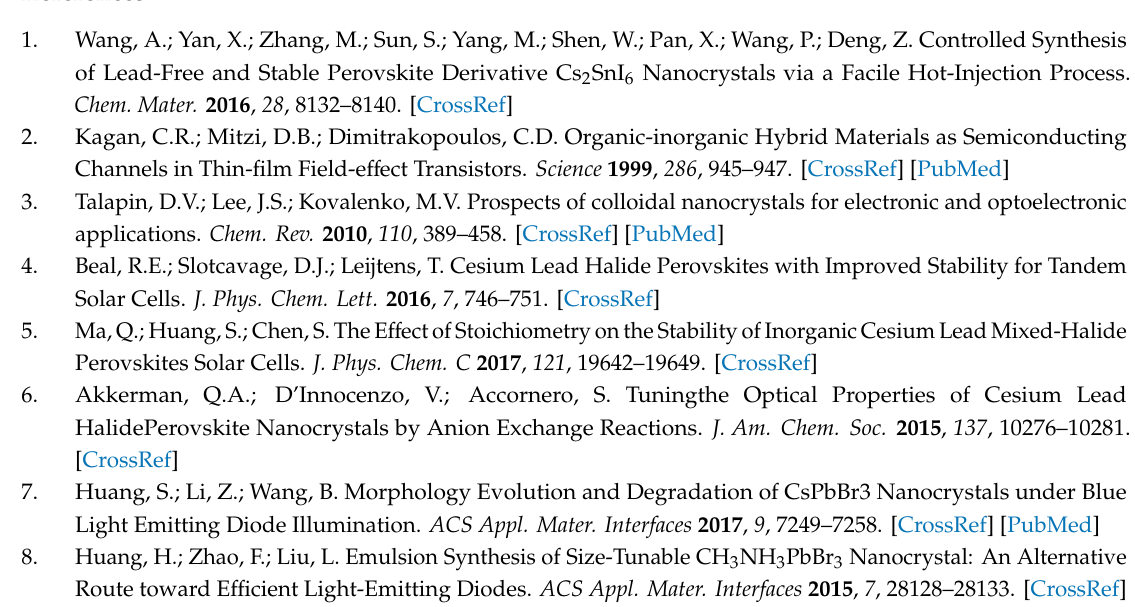
Figure 10. ( a ) The absorption spectra of the samples C1–C5; ( b ) The zoom in view in the range of 300–400 nm.